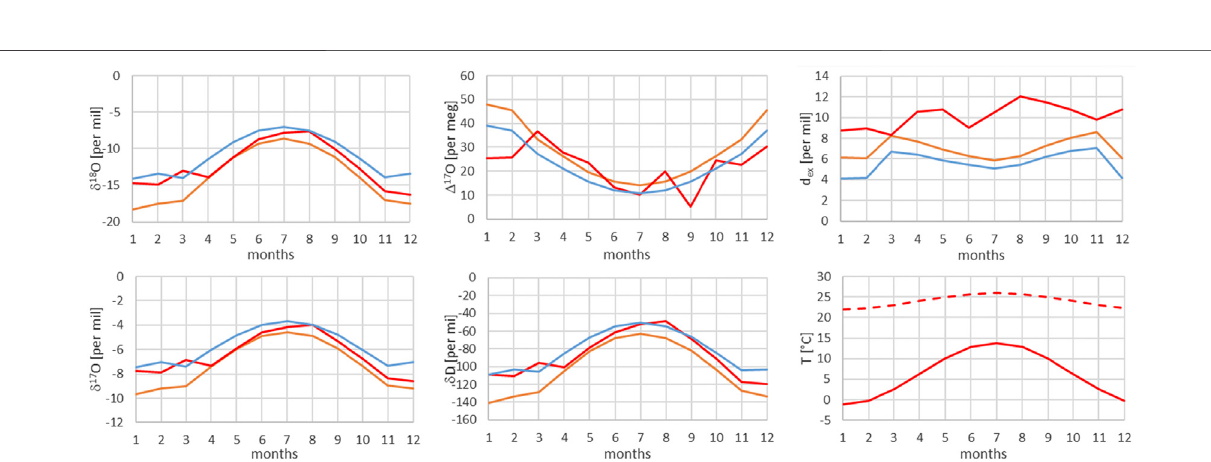
Frontiers in Earth Science |